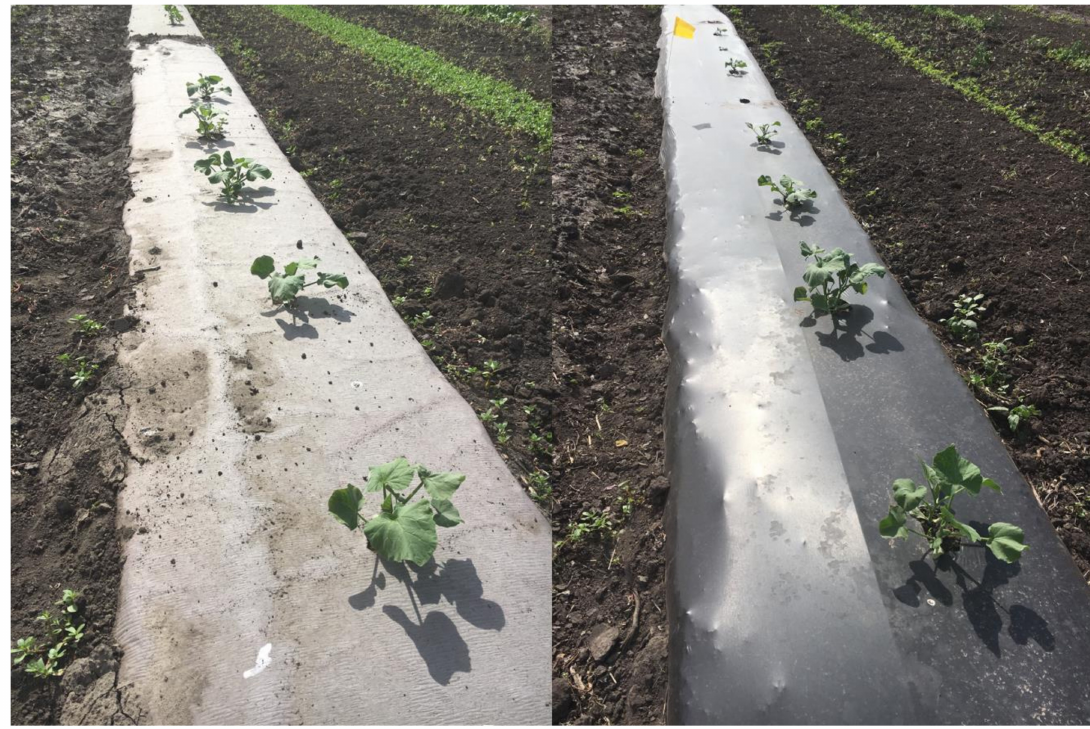
Figure 1. Winter squash ( Cucurbita pepo L.) growing in a paper-based ( left ) versus polyethylene mulch ( right